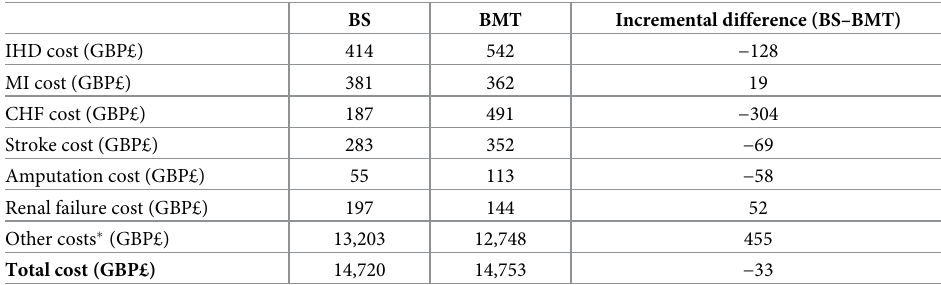
Table 8. Costs of T2DM-related